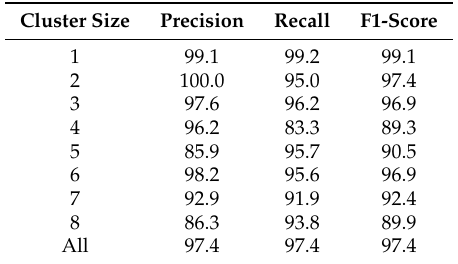
Figure 4. Confusion matrix crossing actual and estimated counts for different cluster sizes. Table 2. Precision, recall and F1-scores for each cluster